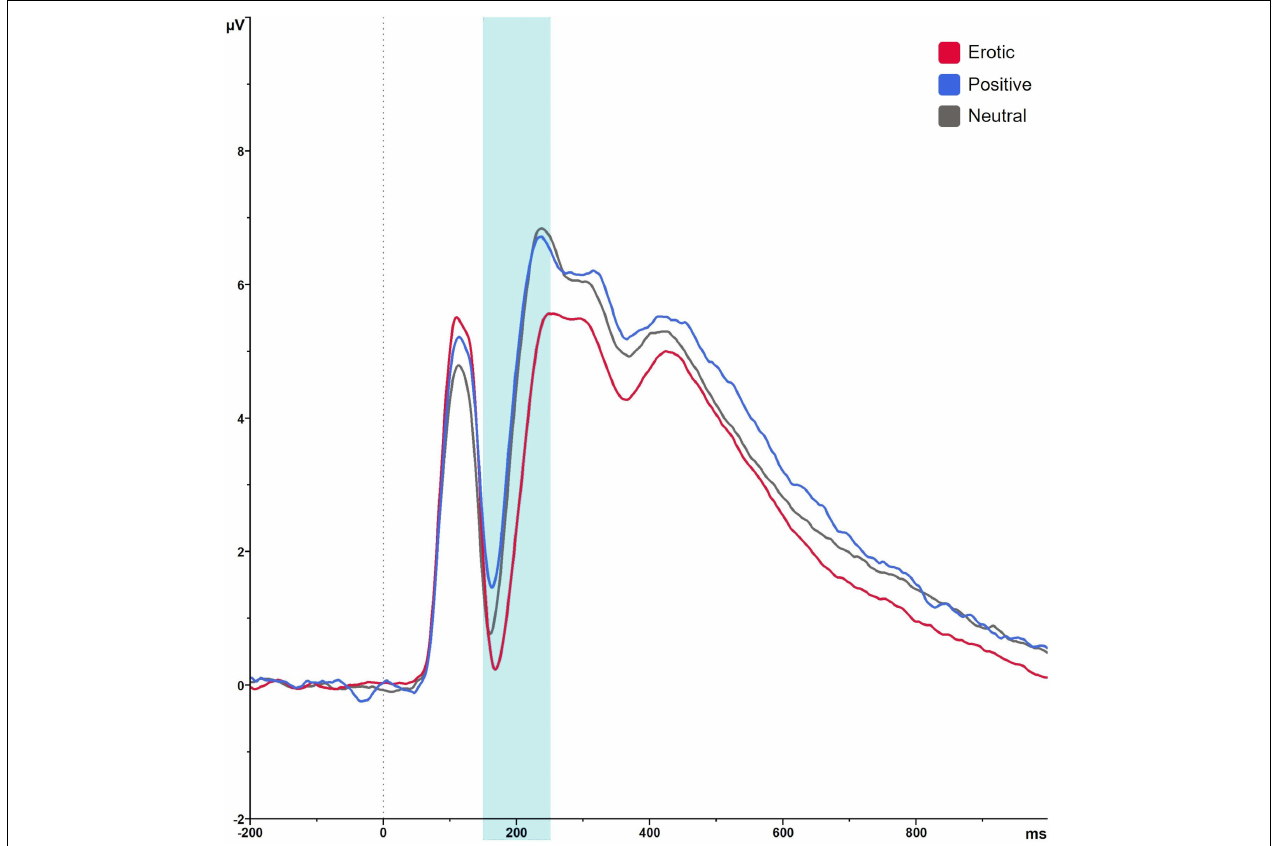
FIGURE 5 | Grand average on electrode PO7 in reaction to erotic, positive and neutral stimuli in the time window 150–250 ms.